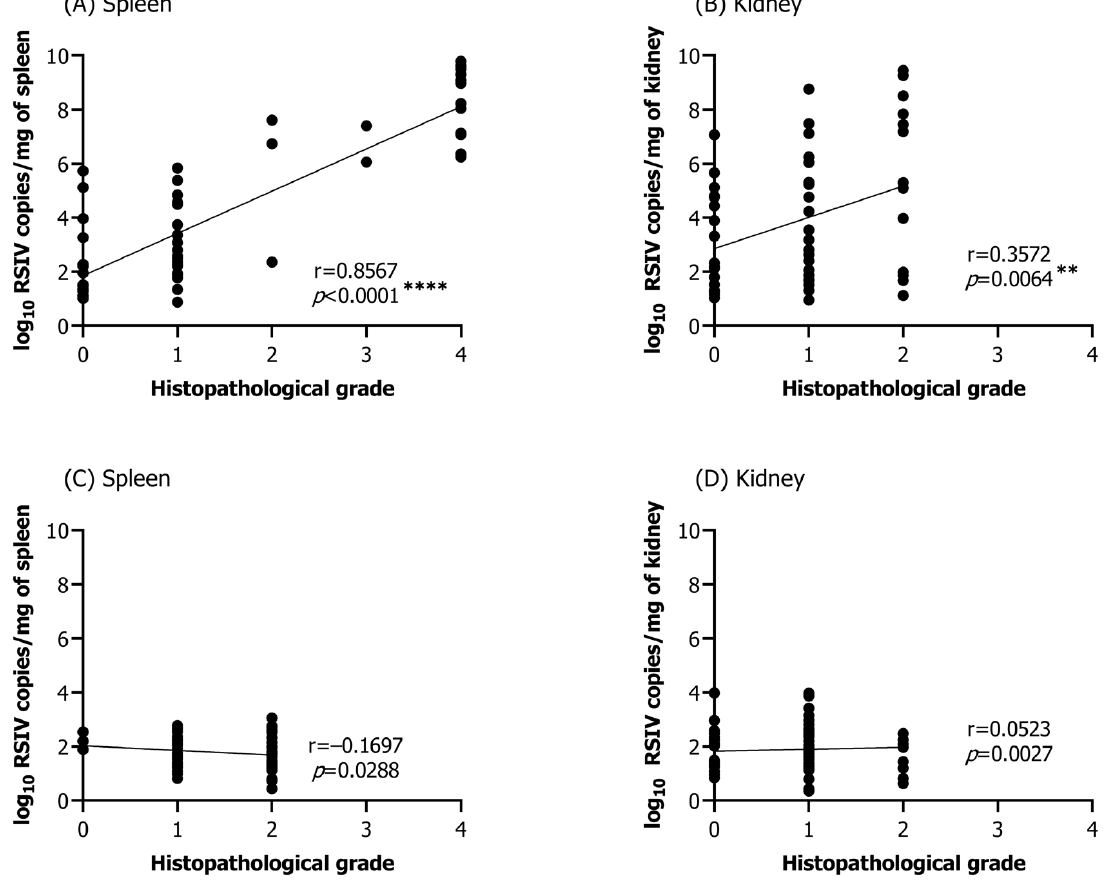
Figure 6. Correlation analysis between the RSIV viral load and histopathological infection grade in the spleen and kidney of rock bream ( Oplegnathus fasciatus ) infected by RSIV immersion at ( A , B ) 25 ◦ C and ( C , D ) 15 ◦ C. Statistical significance was determined using Pearson correlation coefficients (** p < 0.01; **** p < 0.0001).